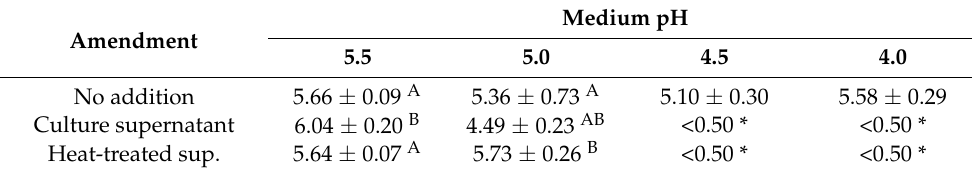
Table 1. Effect of culture supernatant of strain E801 on Fol growth.